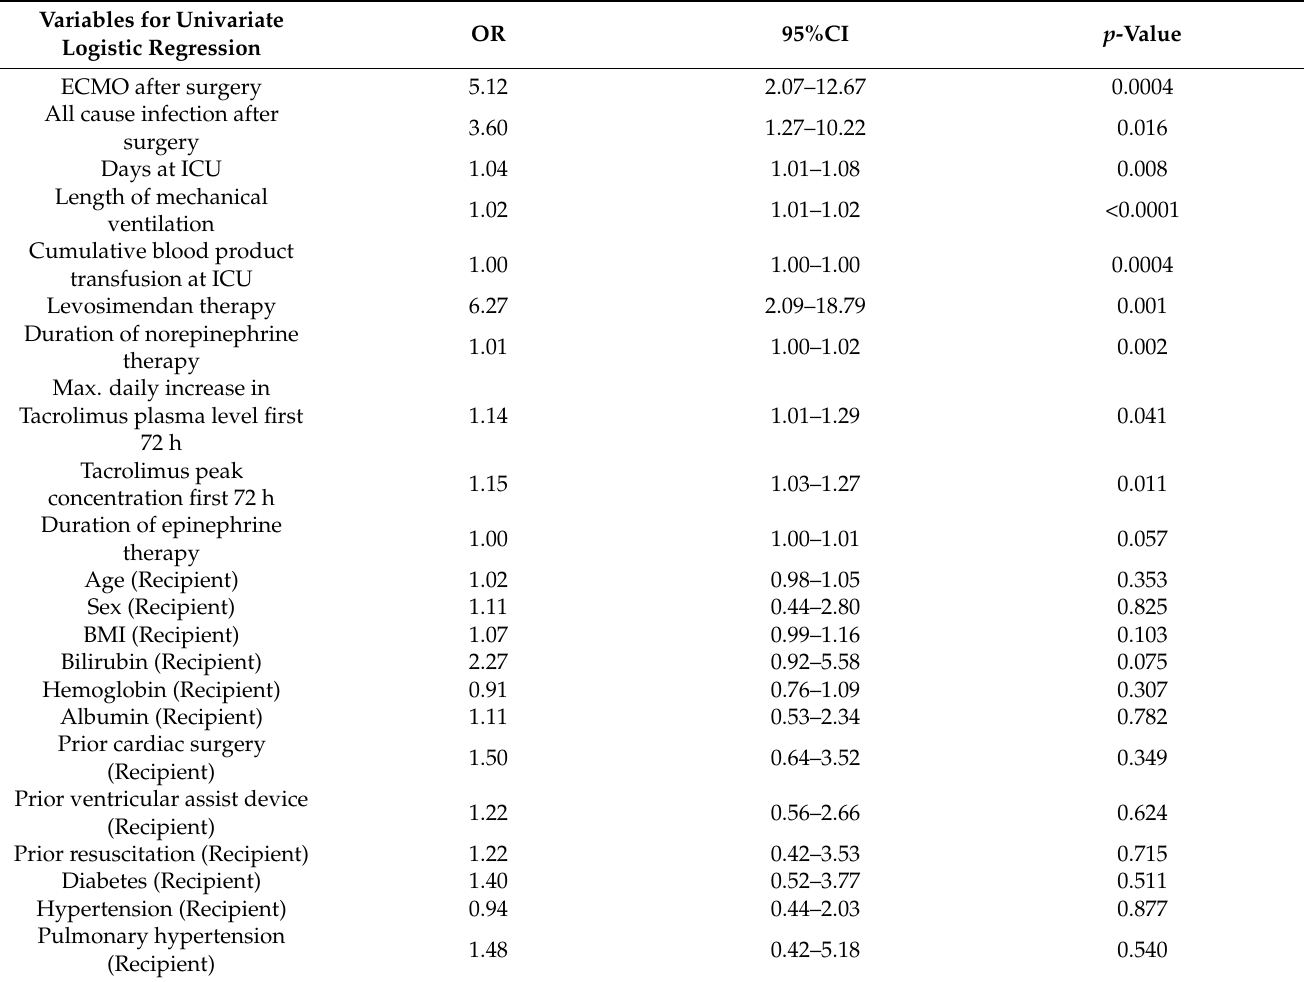
Table A1. Univariate logistic regression for identification of variables associated with acute kidney injury requiring renal replacement therapy after heart